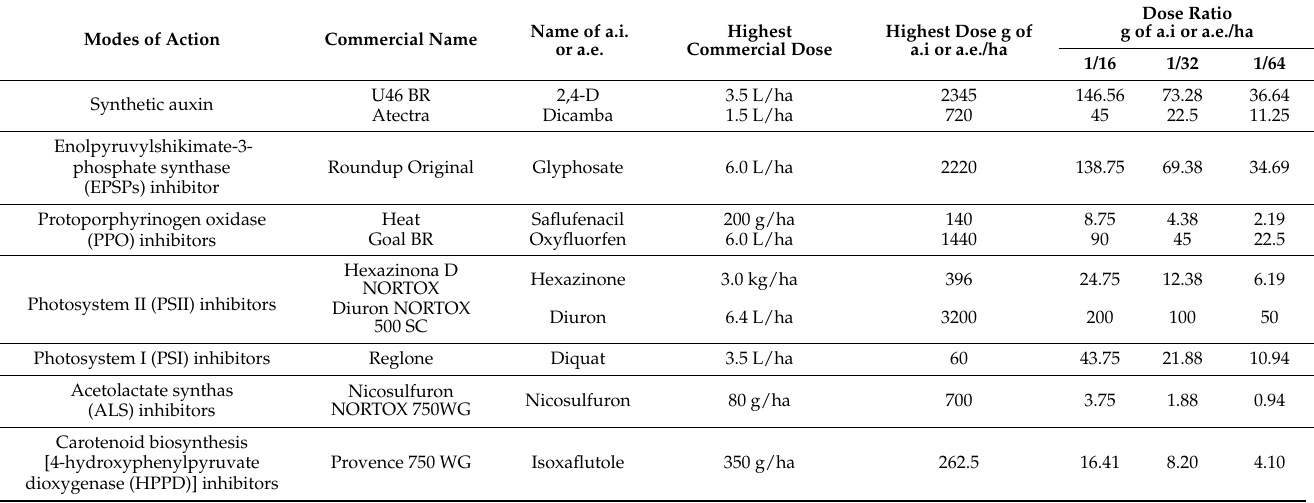
Table 1. Herbicides and dose ratios derived from the highest label dose applied.